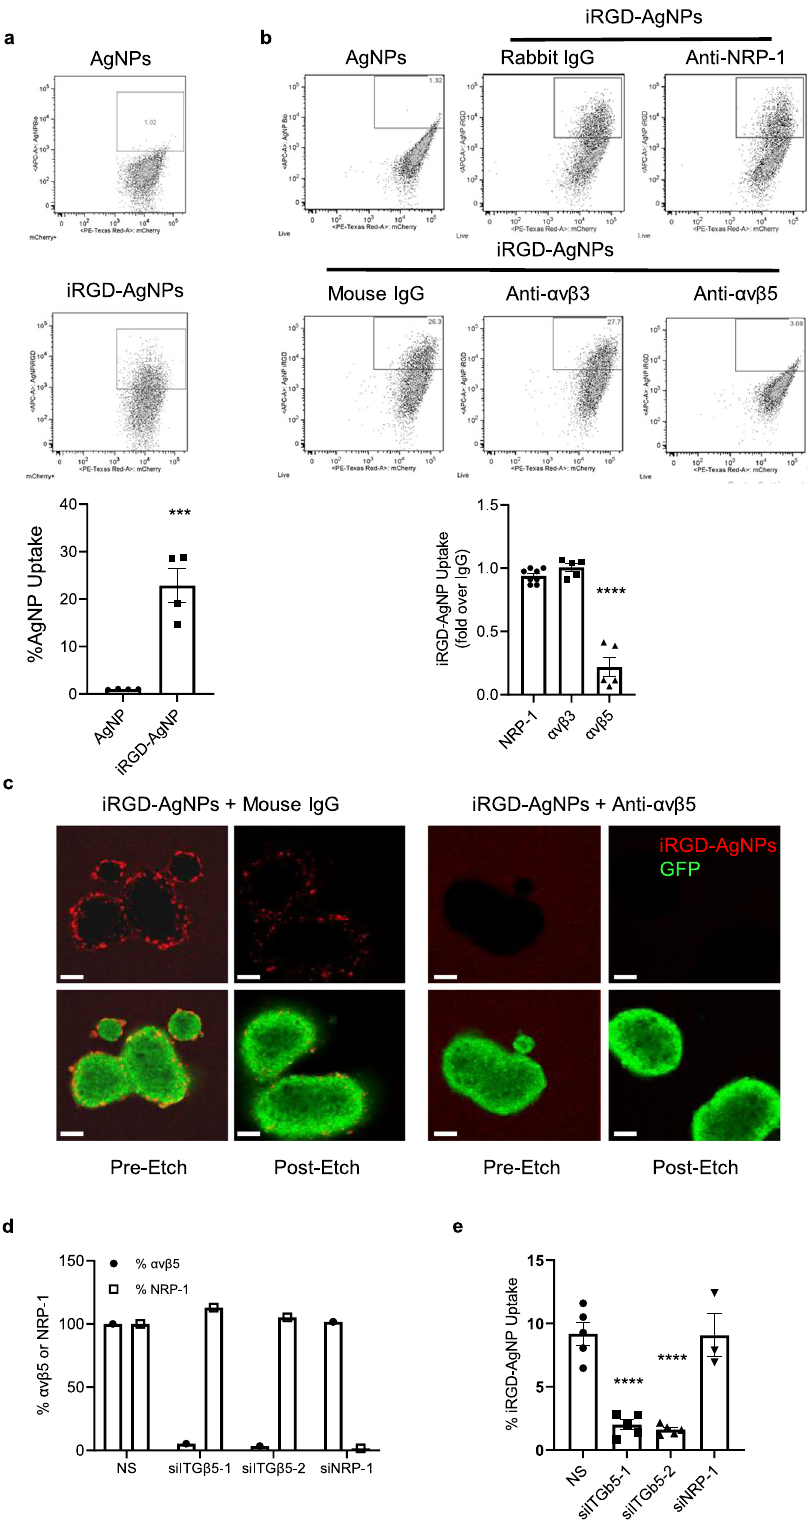
completely inhibited the entry (Fig. 2b, c). Antibodies against α v β 3 integrin and NRP-1 had negligible effect. These fi ndings were con fi rmed using hPCF1424 CAFs in which α v β 5 integrin expression was suppressed by two different β 5 integrin-speci fi c siRNA pools (Fig. 2d, e). NRP-1 siRNA had no effect on AgNP- iRGD entry into the